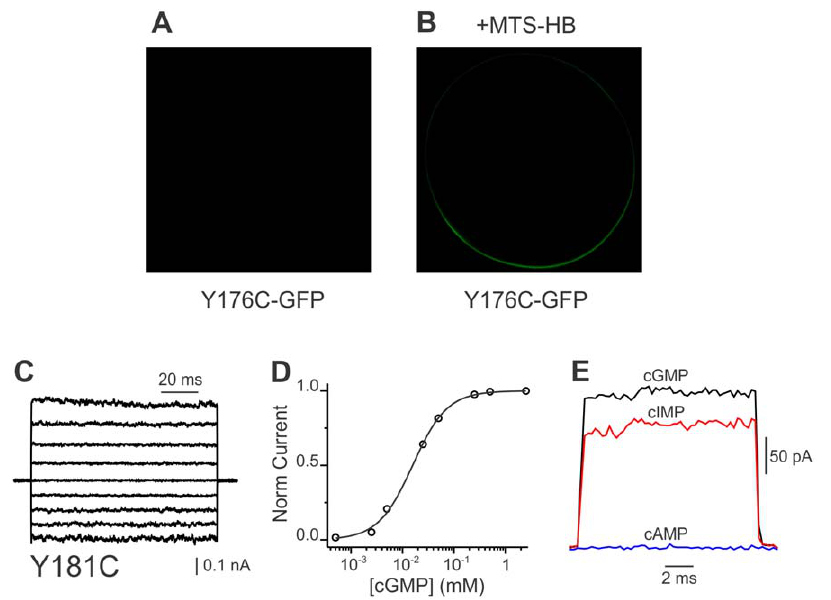
Figure 5. Y176C CNGA1-GFP mutant channels. A. Confocal image of an oocyte injected with cRNA encoding for Y176C CNGA1-GFP channels. We never detected any signs of proper trafficking in . 100 oocytes by standard fluorescence microscopy, suggesting that these channels do not reach the cell surface. B. MTSHB treatment recovers proper trafficking of Y176C mutant channels to the cell surface. Confocal image shows GFP fluorescent signal at the cell surface of an oocyte expressing Y176C mutant channels. MTSHB was injected , 12 h before acquiring the image (n . 25 oocytes). C. Ionic currents in the presence of a saturating cGMP concentration (2 mM), in response to the same voltage protocol as described in Fig. 3A. D. Dose response for cGMP at + 60 mV. Solid line represents a normalized Hill equation fit to the data. The best fit parameter values for K K and n were 16 6 1 m M and 1.30 6 0.05, respectively. From a total of 8 oocytes, the average values for K K and n were 16 6 3 m M and 1.6 6 0.1, respectively. E. Agonist efficacies of rescued Y176C mutant channels. Nucleotide-activated current records shown in the presence of saturating concentrations of each agonist (same as Fig. 3C) were acquired from the same excised patch. Rescued Y176C channels showed a similar efficacy pattern as cysteine-less CNGA1-GFP channels. Similar observations were observed in 4